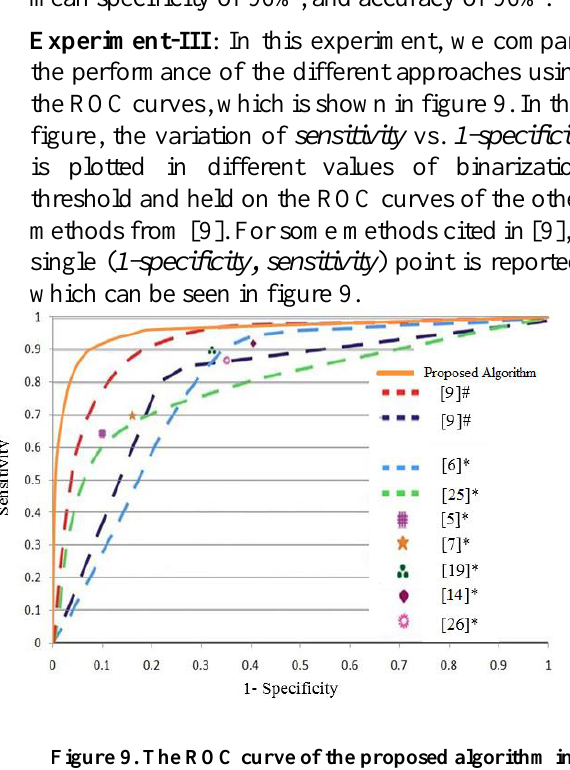
* indicates that these results are from [9].